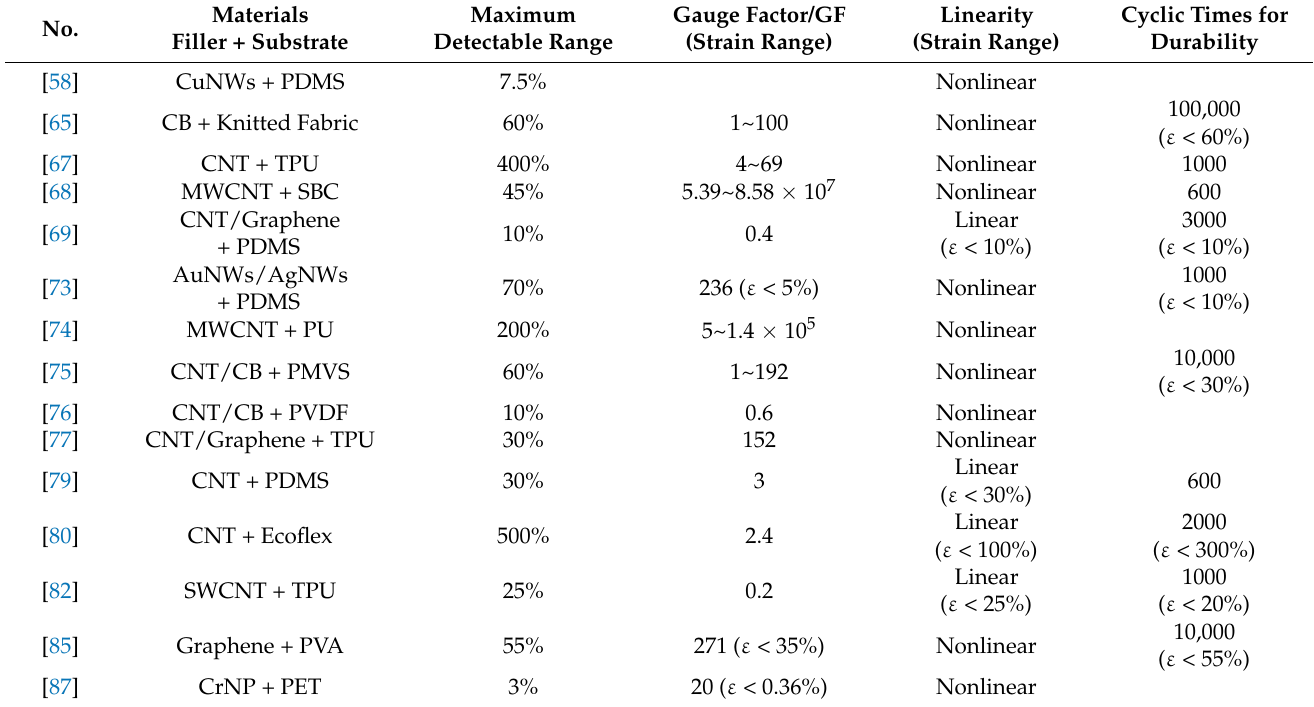
Table 2. Conductive materials and flexible substrates (‘ ε ’ is